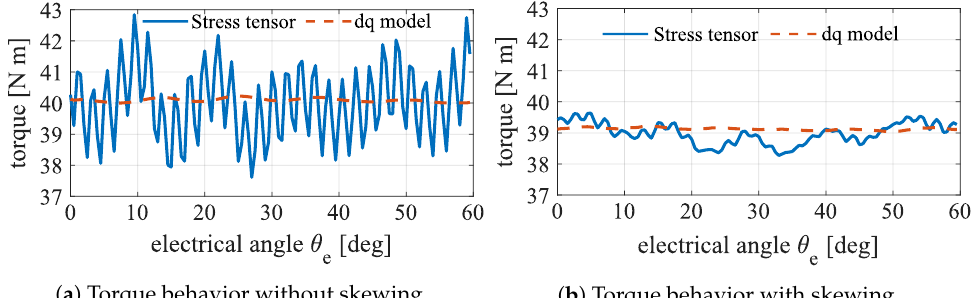
Figure 10. Torque ripple comparison. The Maxwell torque accounts for the slot harmonics showing a remarkable ripple without skewing. The torque via the RFO model considers only the variation of the flux linkage, neglecting the co-energy variation with the rotor position. However, the T dq is a good tool to have an estimation of the average